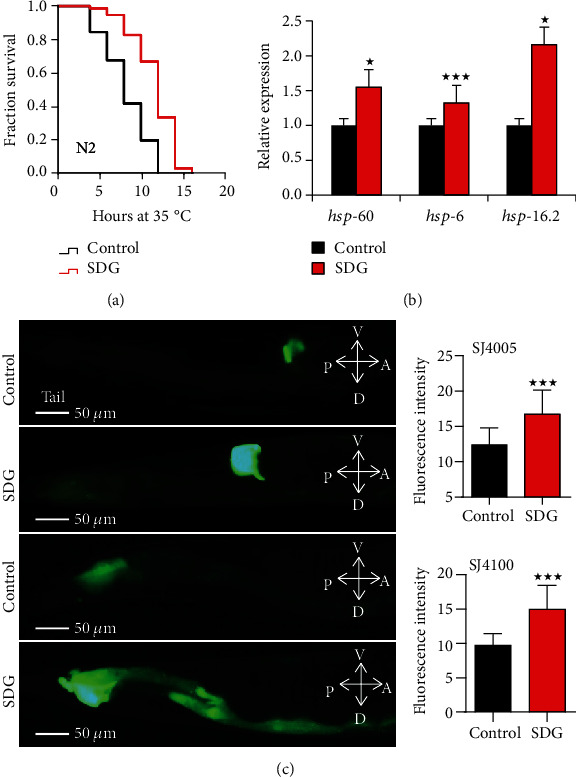
SDG improves the heat stress resistance of C. elegans. (a) The survival of wild-type C. elegans (N2) treated with or without 500 μM of SDG at 35°C. SDG can significantly extend the lifespan by up to 31.6% under heat stress (p < 0.0001, log-rank test). (b) The mRNA level of heat-shock related genes in wild-type C. elegans (N2) treated with or without 500 μM of SDG. The expression of the heat-shock related genes showed a significant difference (p < 0.05, two-tailed t-test). (c) The pictures of green fluorescent at tail in C. elegans SJ4005 zcIs4V (hsp-4::gfp) and SJ4100 zcIs13V (hsp-6::gfp) treated with or without 500 μM of SDG. Worms were observed and photographed using a fluorescent microscope (Leica DM6B) with appropriate filter sets for GFP (magnification: 200x). The quantification of fluorescence intensity showed that the expression of HSP-4::GFP and HSP-6::GFP was significantly increased with SDG treatment (p < 0.0001, two-tailed t-test). A statistically significant p value was calculated by the t-test or log-rank test; ★p < 0.05; ★★★p < 0.0001. The results from repeated experiments and the statistical details are summarized in supplementary Tables S5–S7.